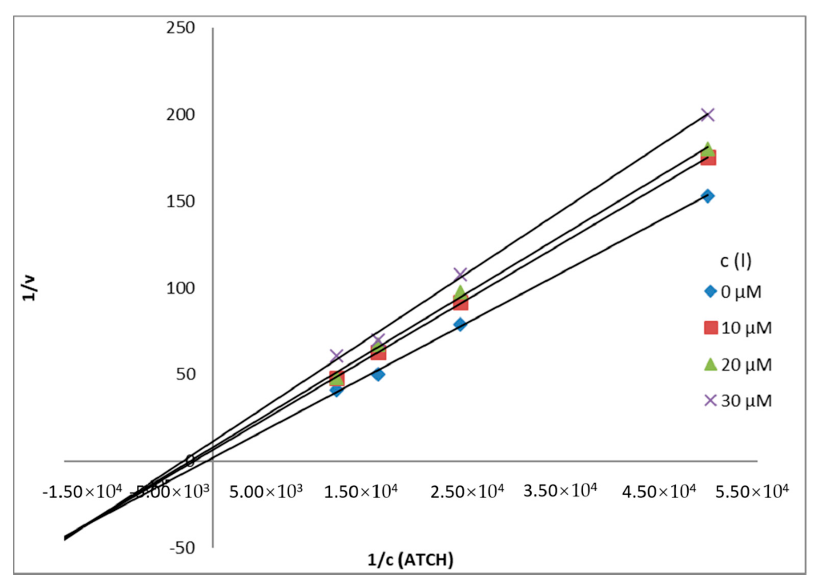
Figure 3. Lineweaver-Burk plot for AChE inhibition (ATCH = acetylthiocholine).